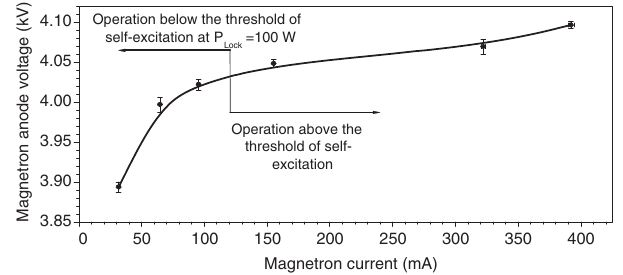
¼ FIG. 4. Magnetron V-I characteristic measured at P Lock 100 W. The solid line (B-spline fit) shows the available range of current with stable operation of the tube at power of the ¼ 100 W. resonant injected signal P Lock